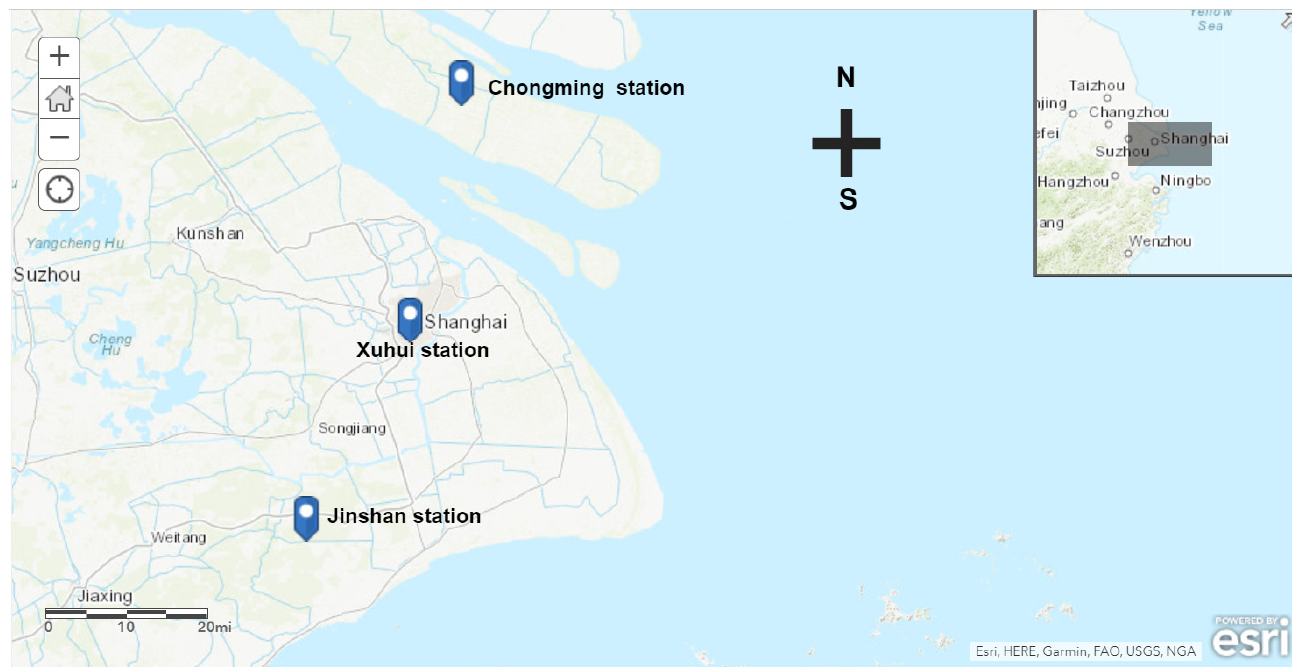
Figure 1. Sampling areas in Shanghai, China.